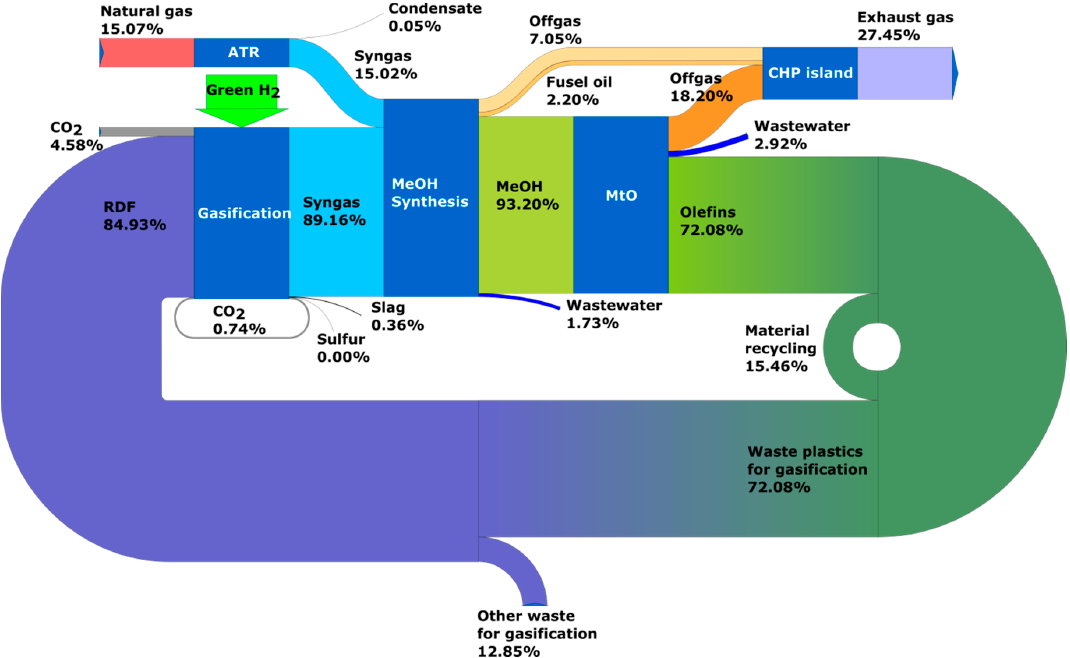
Figure 12. Carbon element distribution in olefins from natural gas and RDF production system with addition of ‘green hydrogen’ (2050).